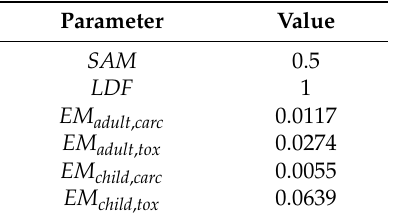
Table 4. Values of SAM, LDF and EM calculated, assuming baseline conditions.